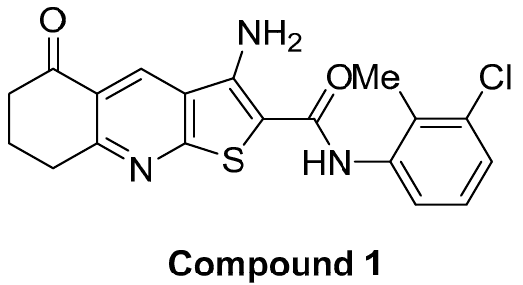
Figure 1. The molecular structure of the anticancer compound 1 , the anticancer thieno[2,3- b ]pyridine derivative.